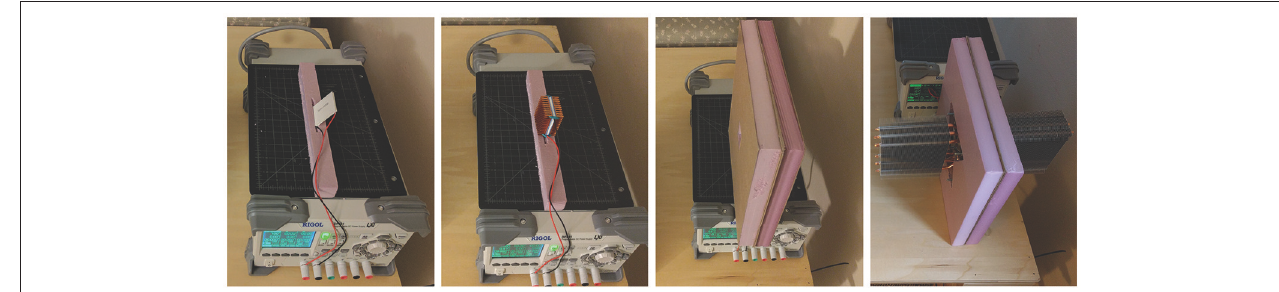
FIGURE 6 | Thermoelectric facade proof of concept mockups.